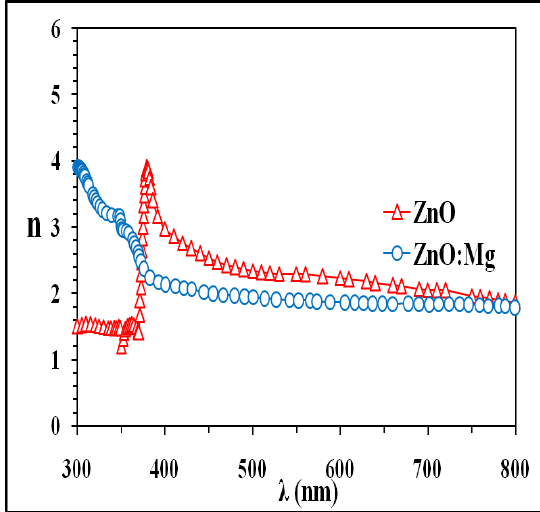
Fig.6: Variation of the refractive index (n) with wavelength of ZnO pure and doped.